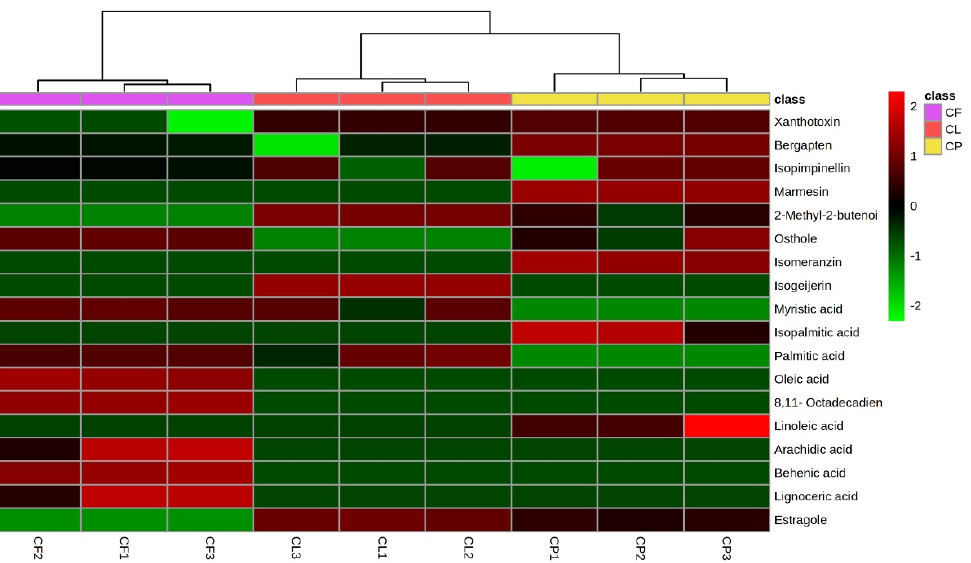
Figure 2. Heat map of identified phytochemicals in the three Cachrys species. CF: C. ferulacea ; CL: C. libanotis ; CP: C. pungens .